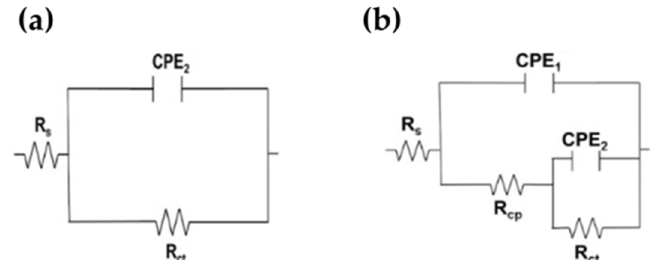
Figure 9. Equivalent circuits proposed for ( a ) SS430 steel and ( b ) carbon steel B450C exposed to SS1 cement extract solution up to 30 days.